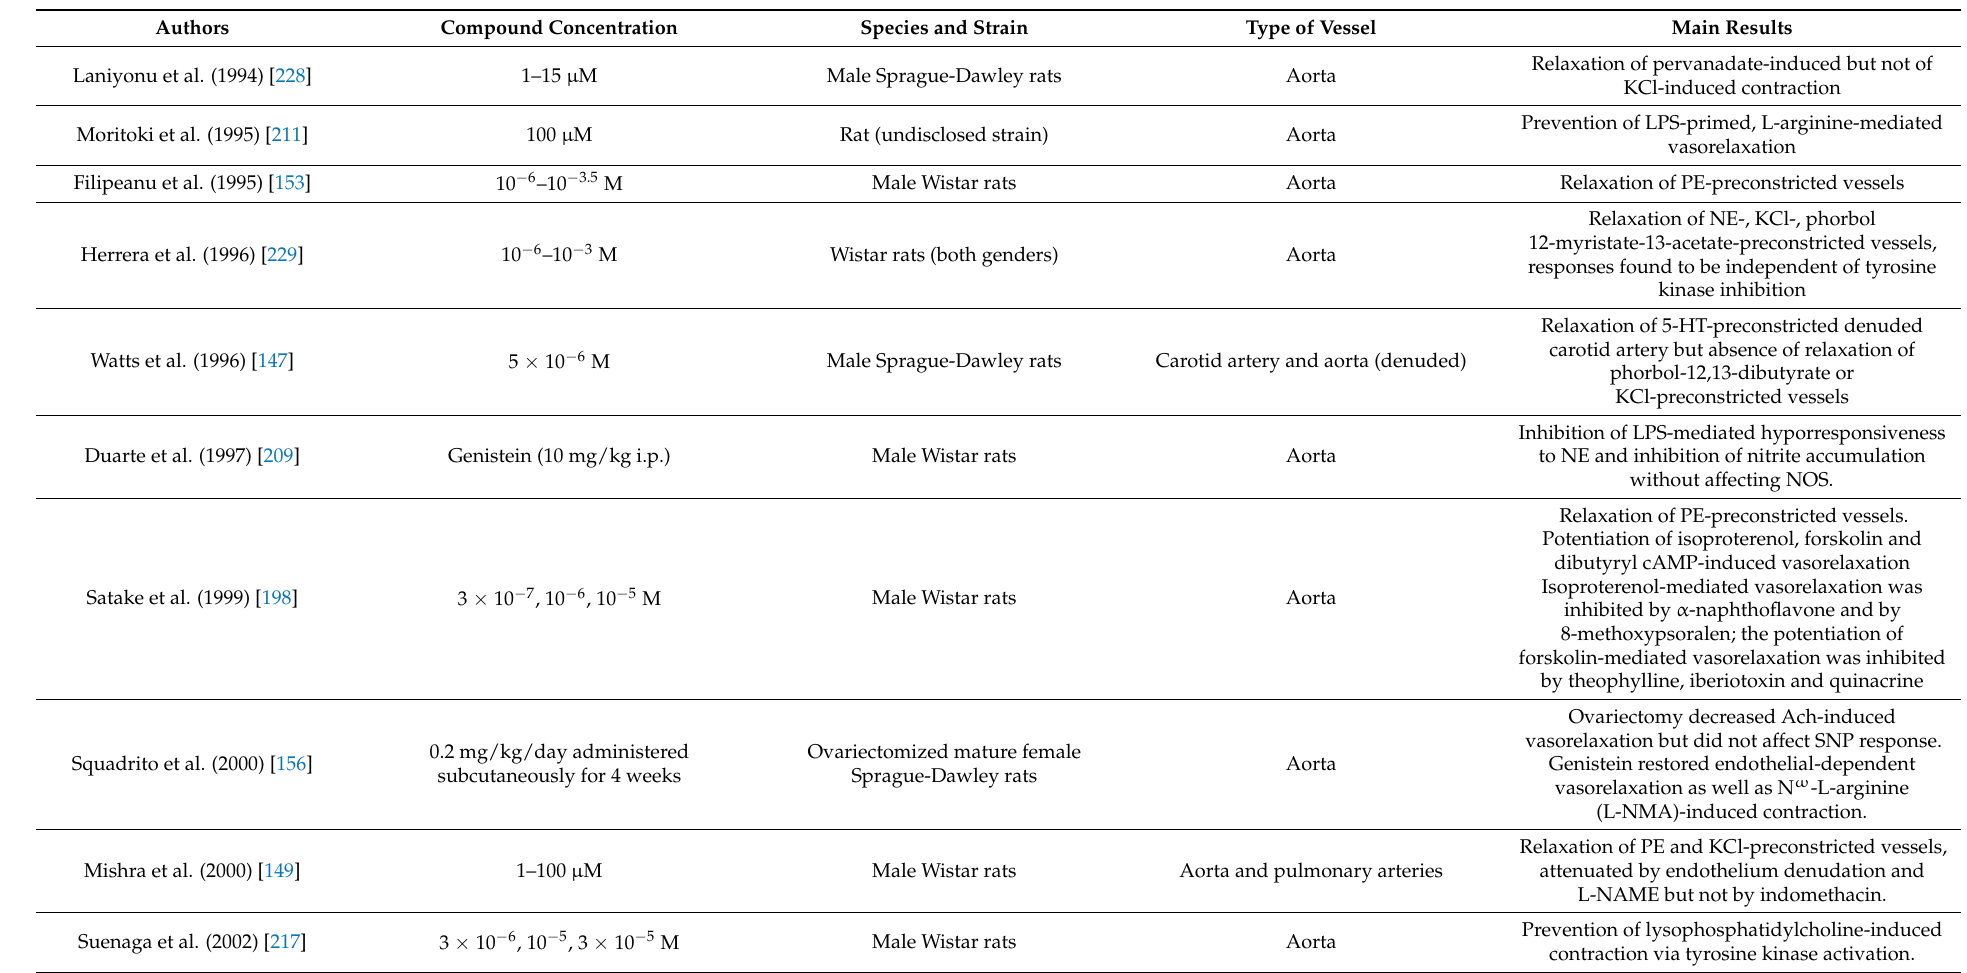
Table 2. Description and main results of in vitro studies on the vasorelaxant activity of